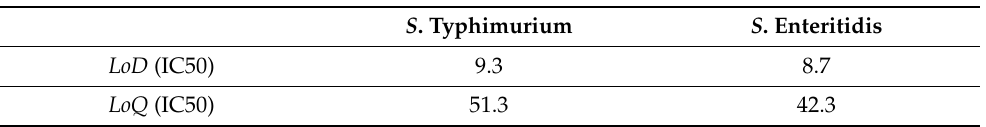
Table 1. LoD and LoQ , expressed as IC50, for each of the two Salmonella strains tested, S. Typhimurium D23580 and S. Enteritidis CMCC4314.